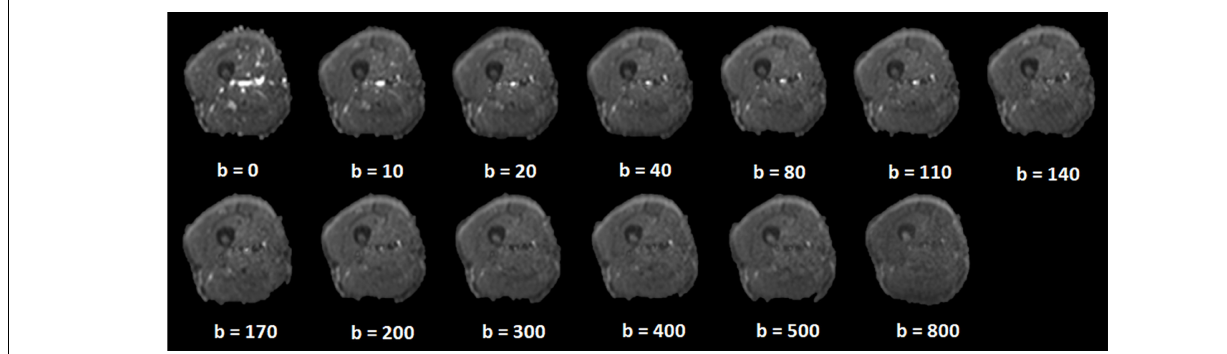
FIGURE 2 | Example of intravoxel incoherent motion images at different b values.